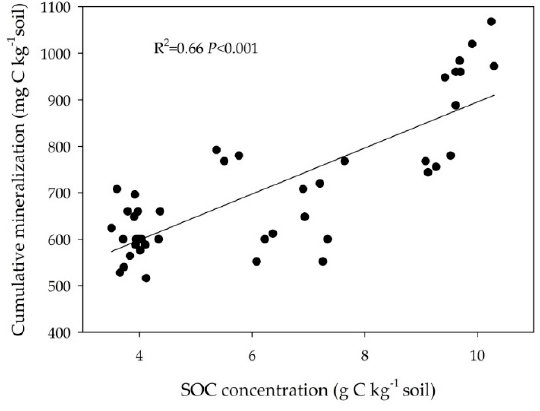
Figure 3. Correlation between SOC concentration and cumulative mineralization.